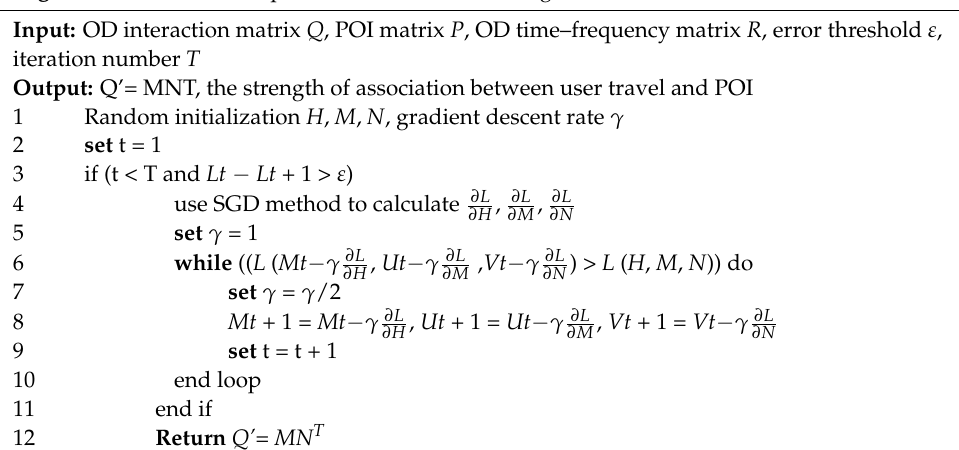
Algorithm 1: Context-coupled matrix factorization